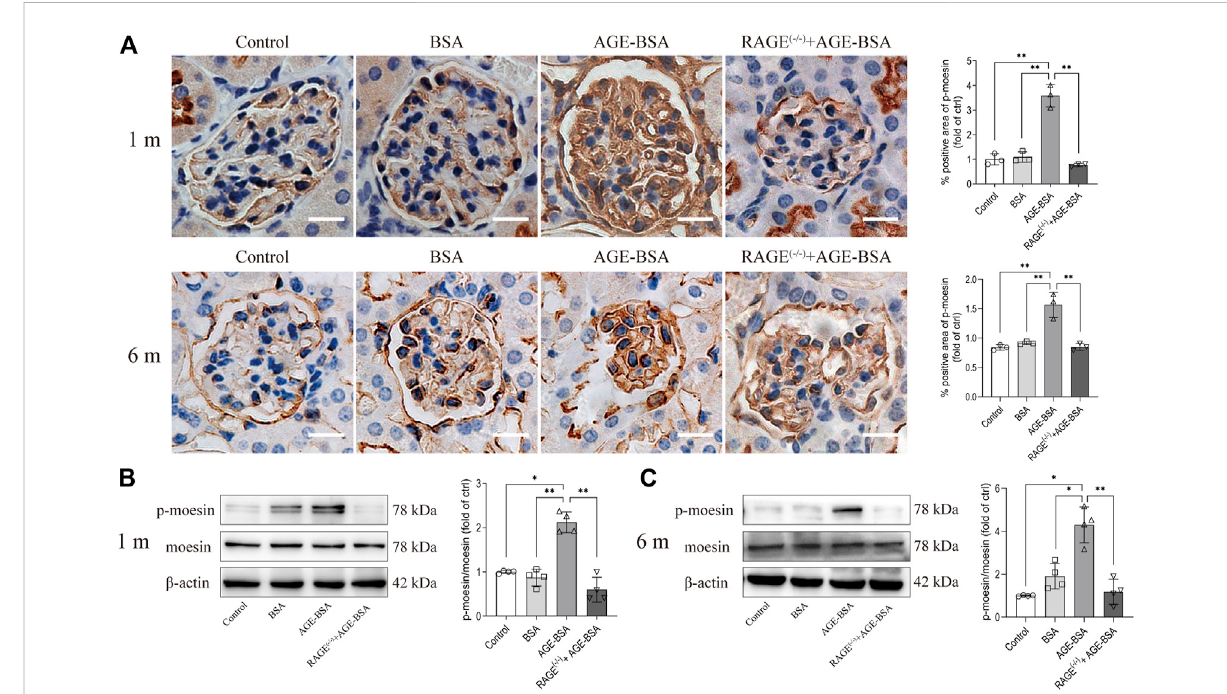
FIGURE 6 AGE-BSAenhancedthelevelofmoesinphosphorylationinmousekidneys. (A) Immunohistochemicalstainingofphospho-moesinat1and6 m after treatment.Scale bar =20 μ m. n = 3and ** p < 0.01. (B,C) Phospho-moesinand totalmoesinexpression in kidneys from AGE-BSA-treated mice for 1 m (B) and 6 m (C) were detected by immunoblotting. n = 4, * p < 0.05, and ** p <